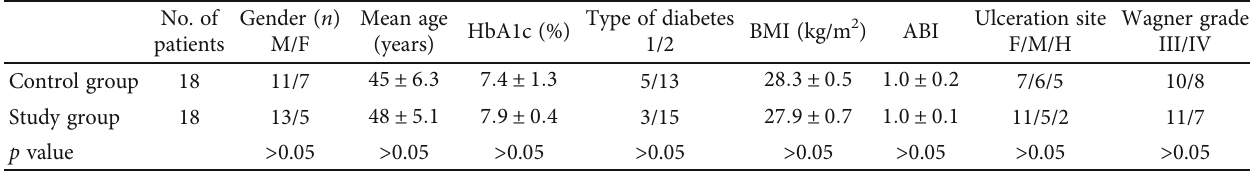
Table 1: Study population demographic characteristics.